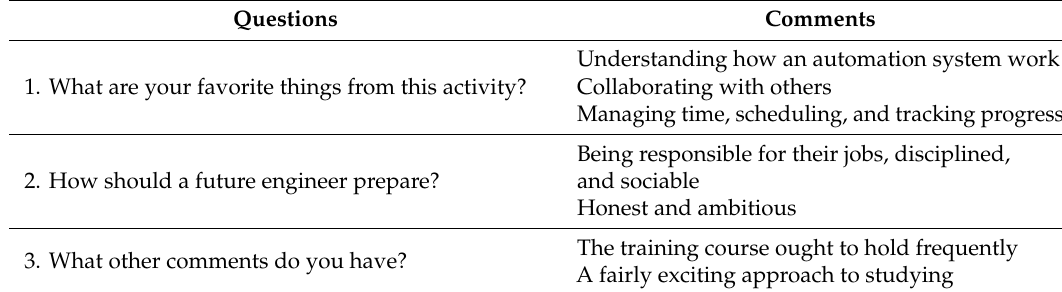
Table 11. Partners’ comments.